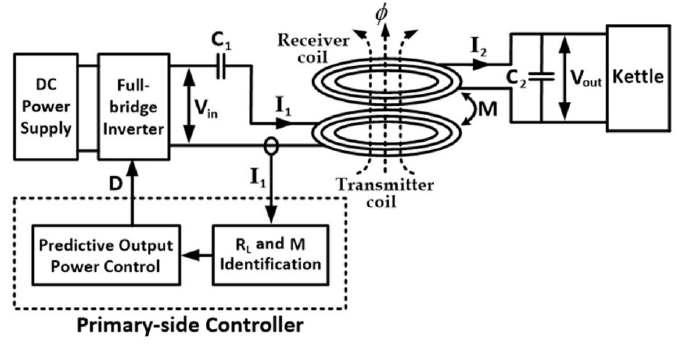
Figure 1. The proposed wireless power transfer (WPT) system.